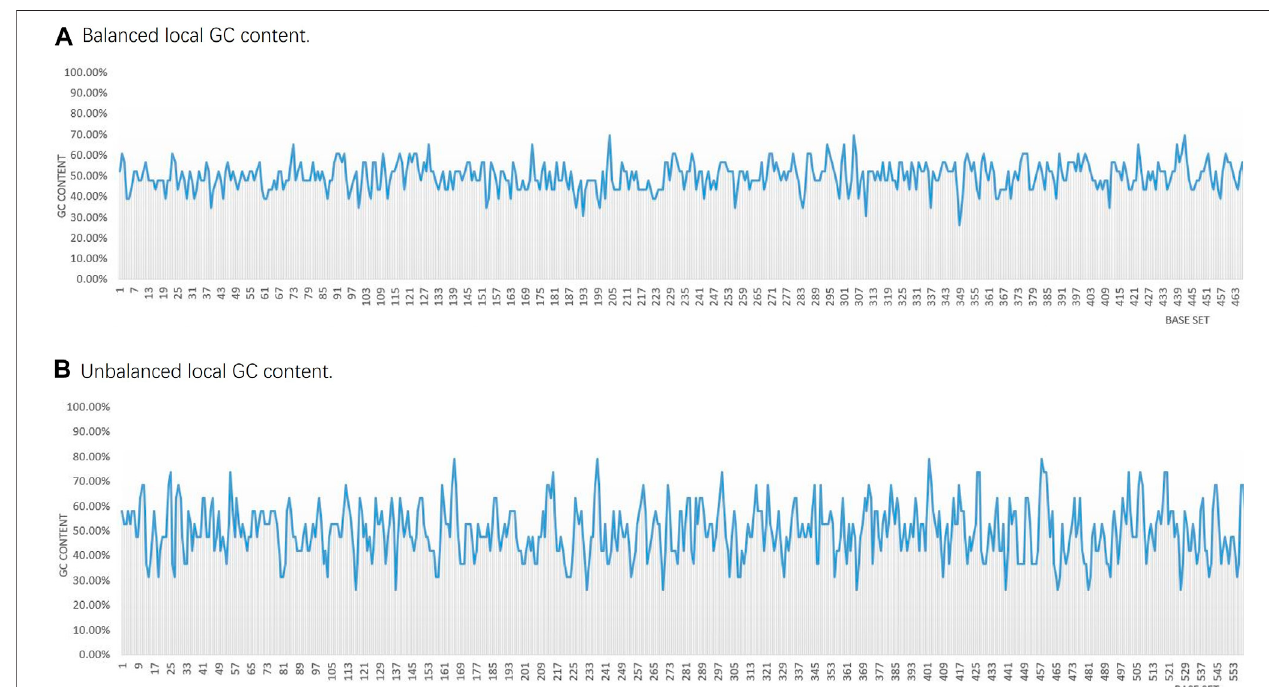
FIGURE 6 | Statistical comparison of partial local GC base content in the two DNA storage systems. (A) This scheme carries out the local GC content control. (B) Fountain coding scheme without the local GC content control.